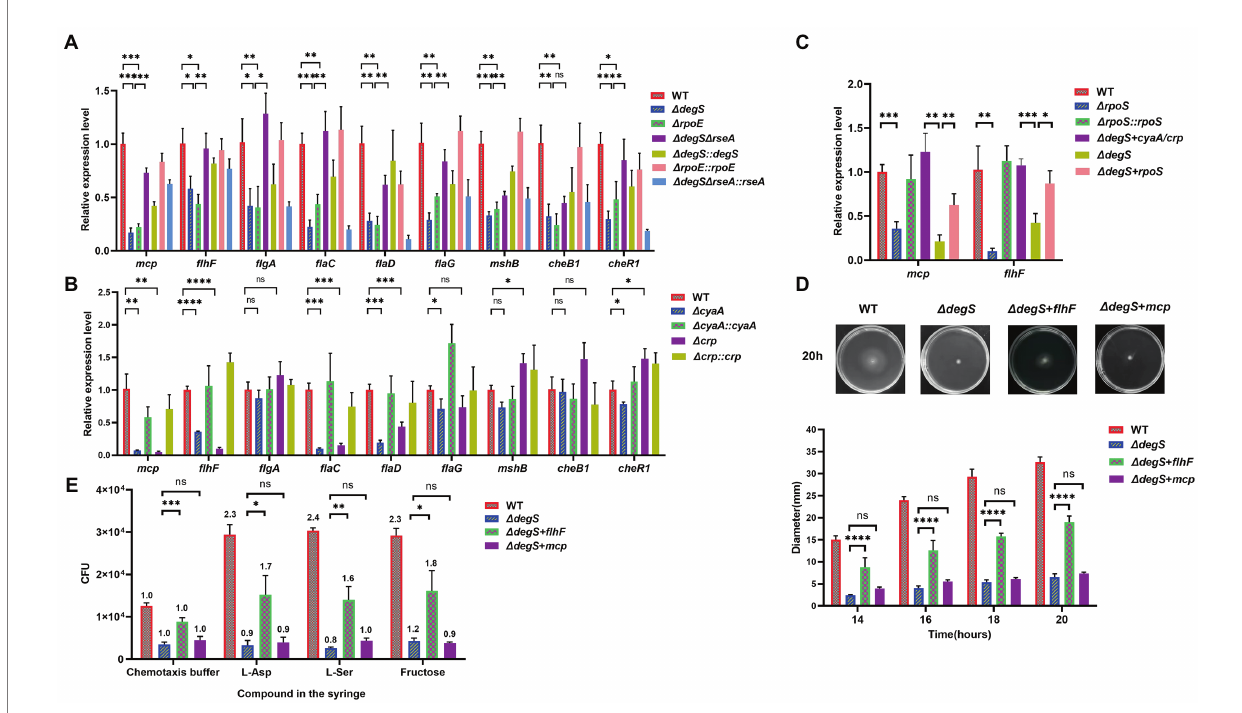
FIGURE 4 The effect of DegS on Vibrio cholerae motility may involve the expression of FlhF. (A,B) The mRNA levels of nine flagellum synthesis- and chemotaxis- related genes in WT, Δ degS , Δ rpoE , Δ rpoE::rpoE , Δ degS Δ rseA , Δ degS Δ rseA::rseA , Δ degS::degS , Δ cyaA , Δ cyaA::cyaA , Δ crp , and Δ crp::crp strains (unpaired t -tests). (C) The mRNA levels of mcp and flhF in WT, Δ degS , Δ rpoS , Δ rpoS::rpoS , Δ degS + cyaA / crp , and Δ degS + rpoS strains (unpaired t -tests). (D) The swimming motility of WT, Δ degS , Δ degS + flhF , and Δ degS + mcp strains was assessed. The representative pictures for the swimming zones are obtained at 20 h. Statistical analyses were performed using a two-way ANOVA. ****, p < 0.0001 between two strains; ns, not significant. (E) The analysis of chemotactic responses to aspartate, serine, and fructose for WT, Δ degS , Δ degS + flhF , and Δ degS + mcp strains. Error bars indicate the SDs based on three replicated experimental values ( n = 3). *, p < 0.05; **, p < 0.01; ***, p < 0.001; ns, not significant (unpaired t -tests). Numbers on top of each bar indicate the relative chemotactic indexes (RCI).